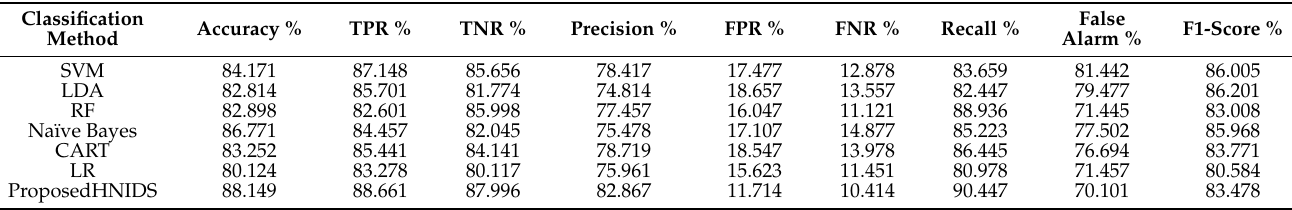
Table 9. Experimental results of MCC on KDD-Train + dataset.